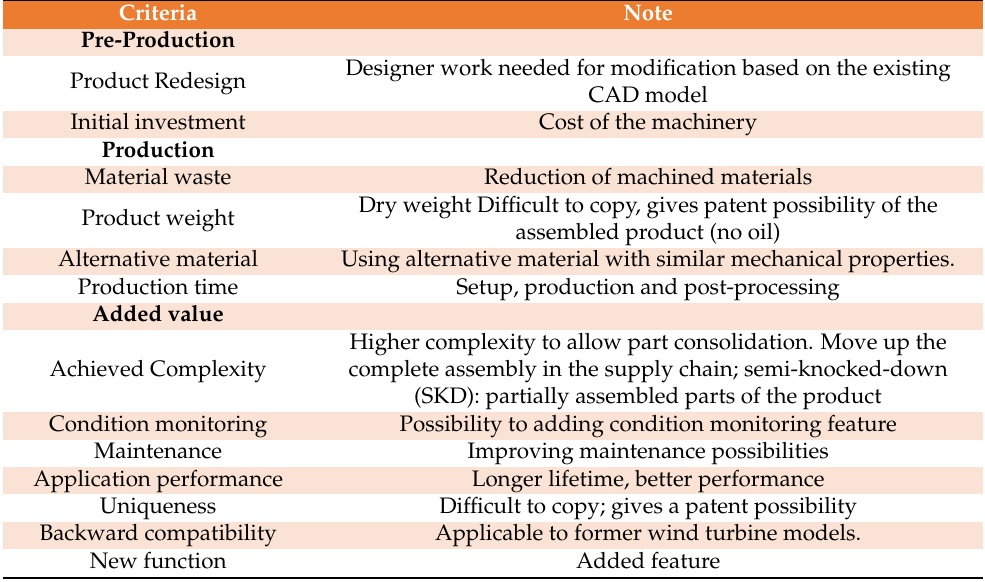
Table 1. Application